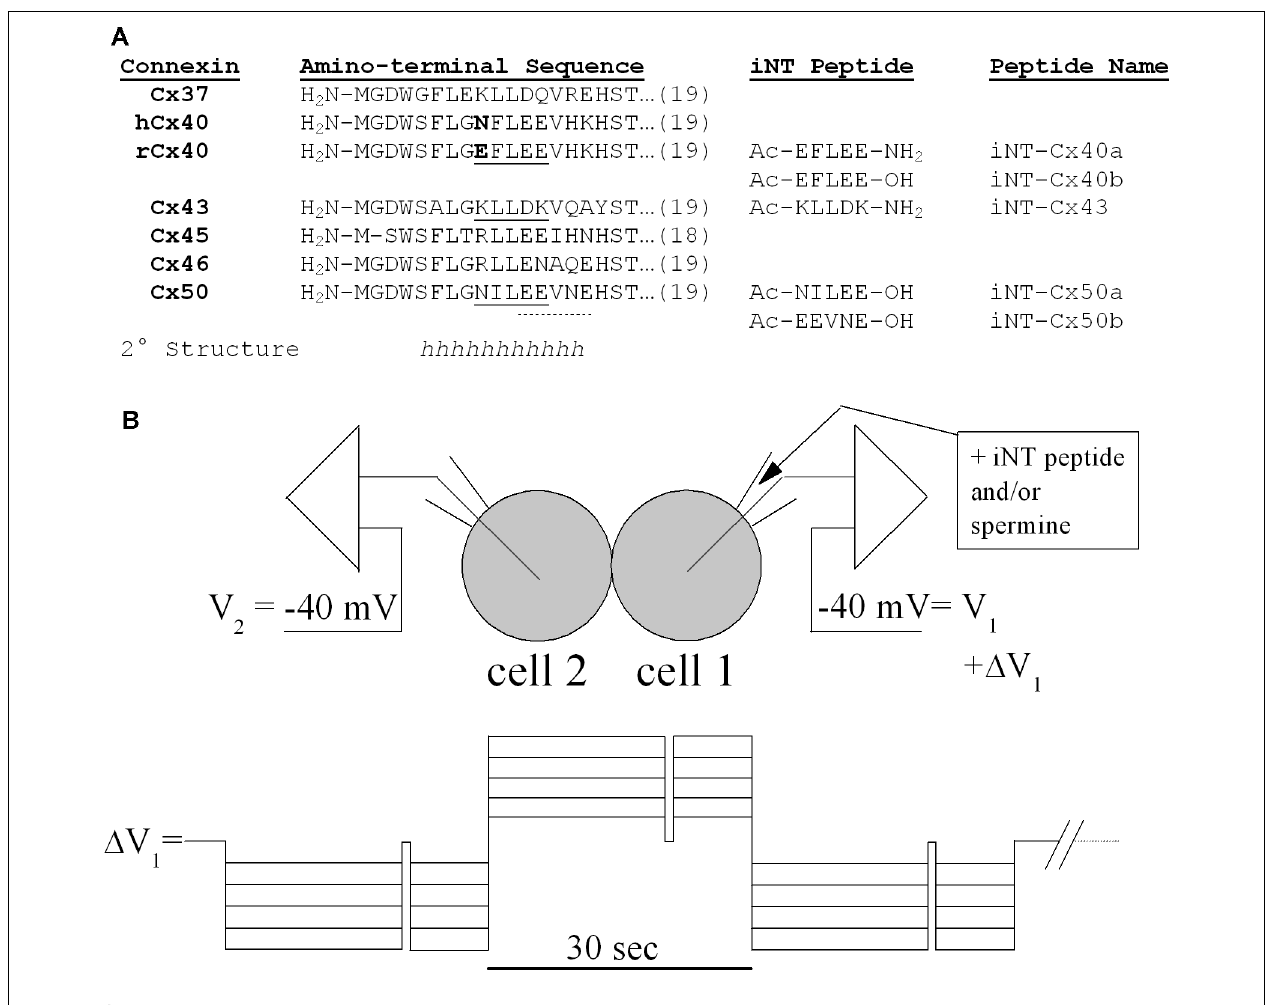
FIGURE 1 | (A) The amino acid sequences of the first 18 or 19 amino acids are shown for six different connexins and aligned with each other. The sequences in this NT region are identical for the homologous connexins in rodents or humans except for Cx40 (which differs at position 9 as shown in bold). A substantial part of the NT domain is likely to form α -helices (h) based on consensus secondary structure predictions (Veenstra and Lin, 2006), nuclear magnetic resonance studies (Kyle etal., 2009), and homology modeling to the X-ray structure of Cx26 (Maeda etal., 2009).